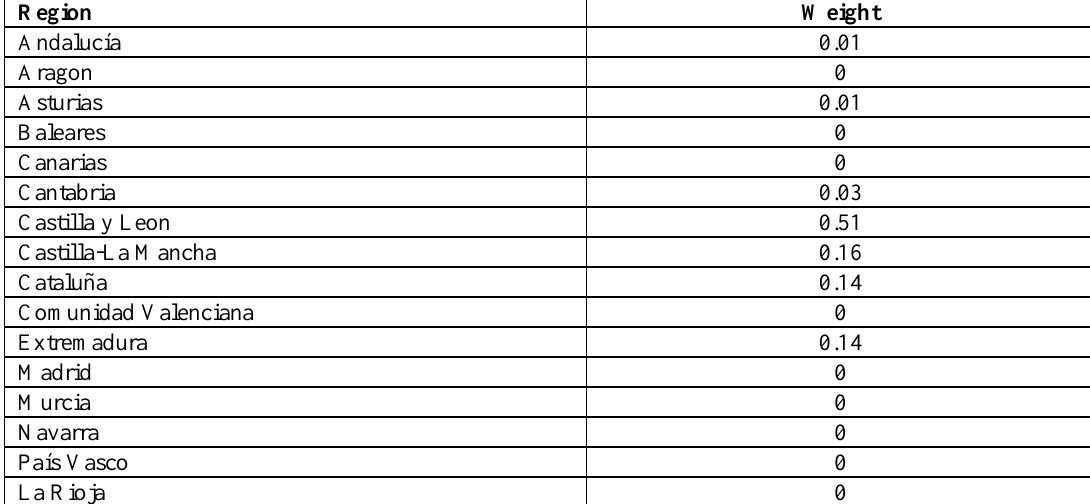
Table 5 : SCM regional weights